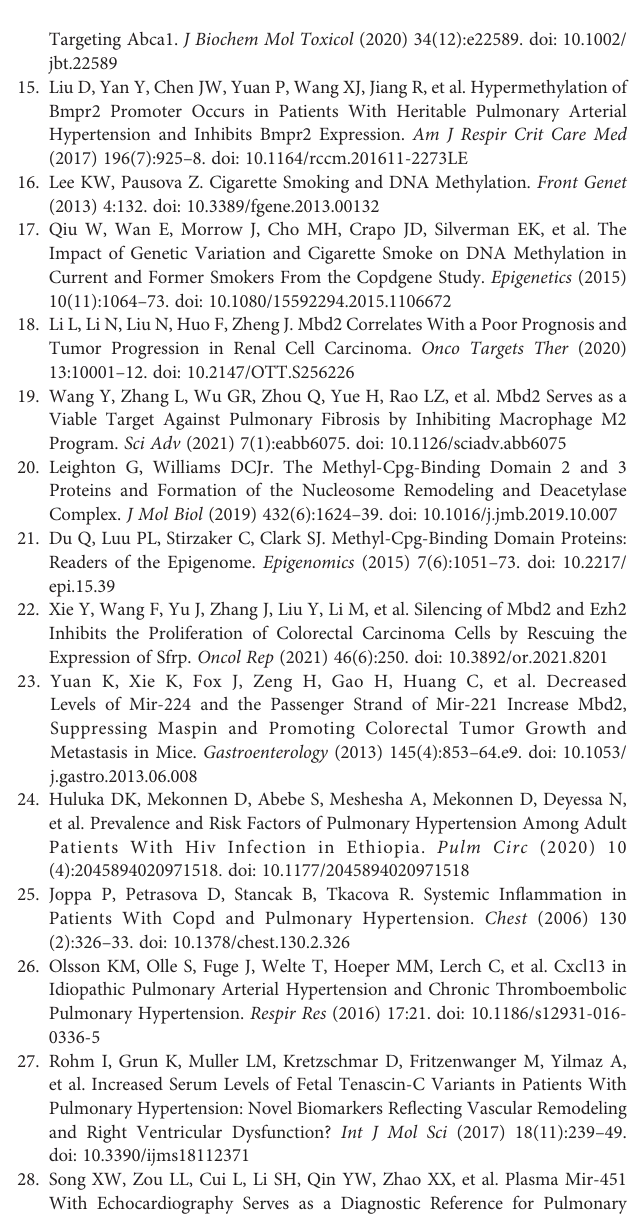
Supplementary Figure 3 | The decrease in BMP2 protein in cigarette smoke (CS)-induced pulmonary hypertension (PH). Representative results of coimmunostaining of BMP2 and a -SMA in lung sections of the controls or PH groups, and the air group rats or smoking group rats. All images are 400× magni fi cation. Scale bar = 20 m